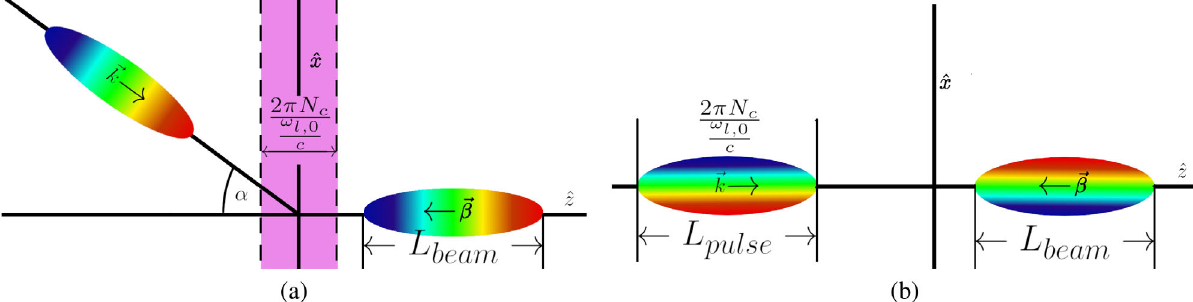
FIG. 2. Schematic of the two possible geometries for a chirped laser pulse. (a) Longitudinally chirped laser pulse. The shaded area indicates the interaction length ( L I ). The model for the chirp is set up such that a pulse that travels along the z -axis and is rotated by an angle α . (b) Transversely chirped laser pulse. Here the length of the interaction is the length of the laser pulse after imposing a spatial